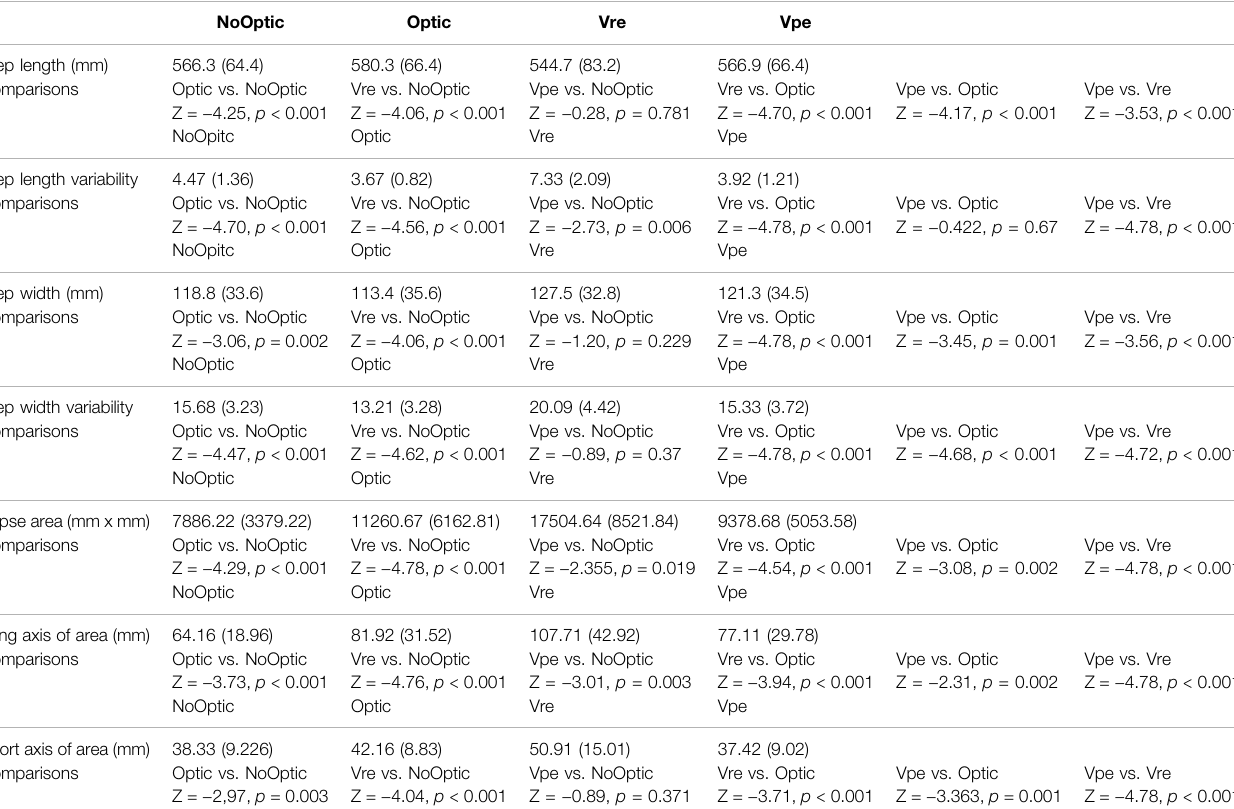
TABLE 1 | Mean and standard deviation of step length, step length variability, step width, step width variability, ellipse area, long axis of ellipse area, and short axis of ellipse area with